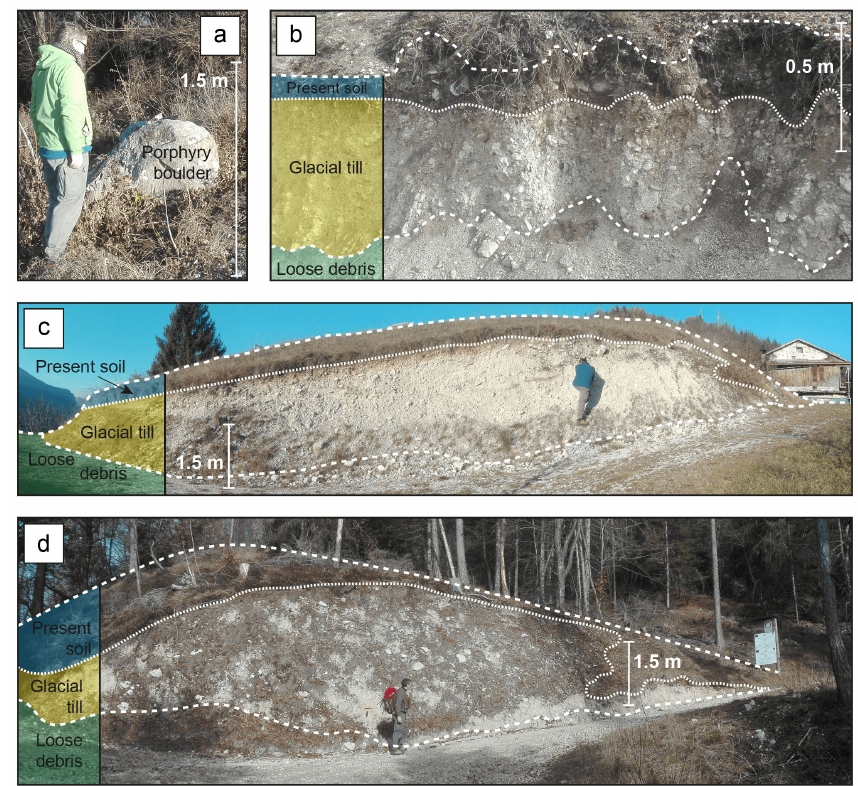
Figure 4. Photos taken in the middle sector of the Valsugana Valley. When present, stratigraphic layers are separated by dotted/dashed white lines. (a) A porphyry boulder, located on top of Col del Gallo mount; (b) a section of a lateral moraine of the Brenta Glacier, located on top of the Novegno mount; (c) a moraine, located on the southern side of the Col del Gallo; and (d) a moraine, located in the Sorist